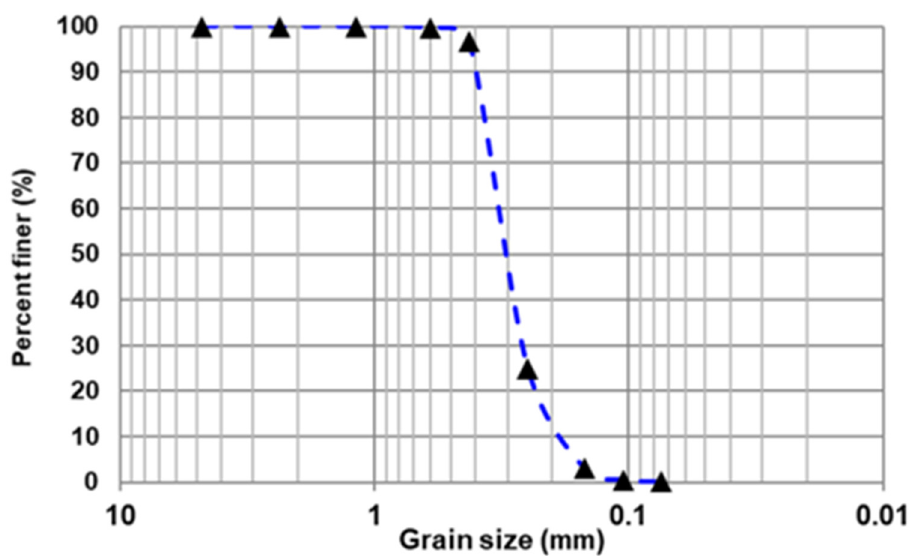
Figure 1. Grain size distribution of uniform sand.